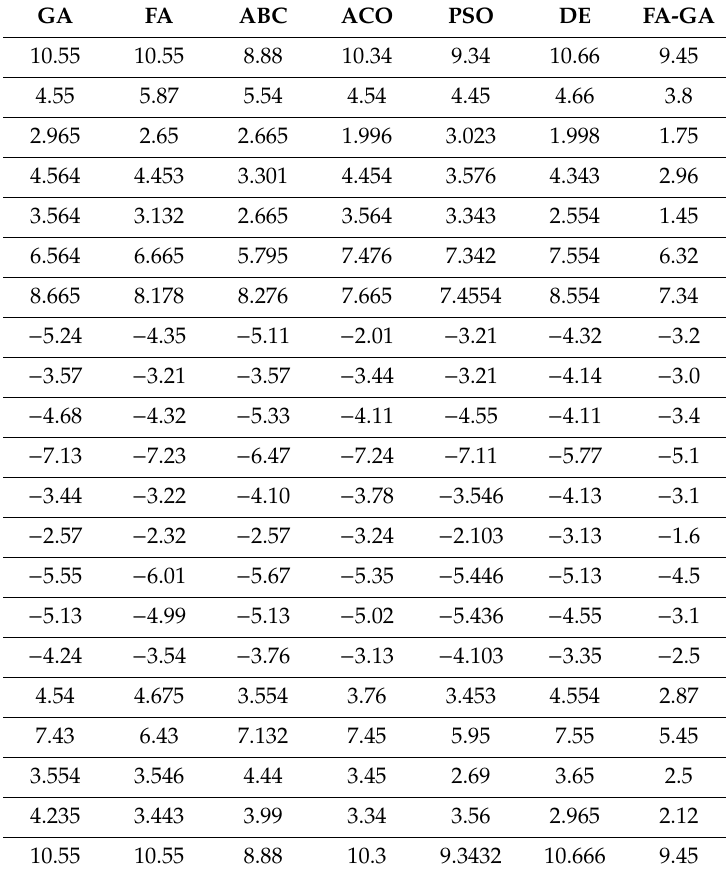
Table 4. Temperature error di ff erences based on the considered approaches.